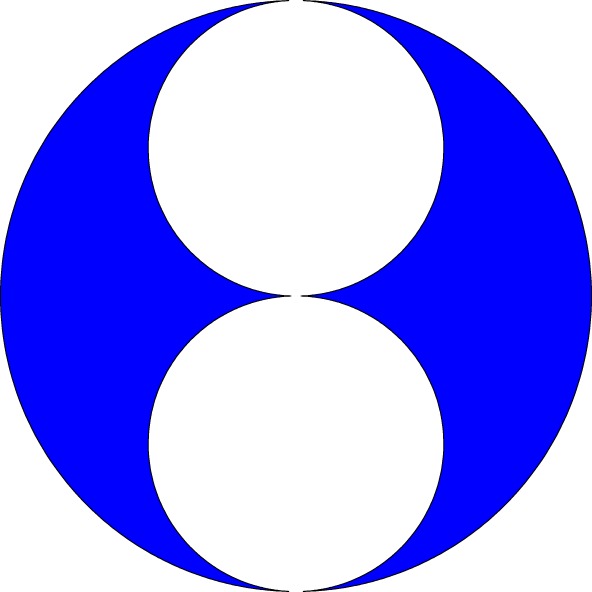
Pore shapes with ρ=0.5 and θ=2π/3. The pores are close to touching at three near cusps. The two ‘outer’ pore boundaries together appear to form a single circumscribing circular boundary (but with two small gaps).